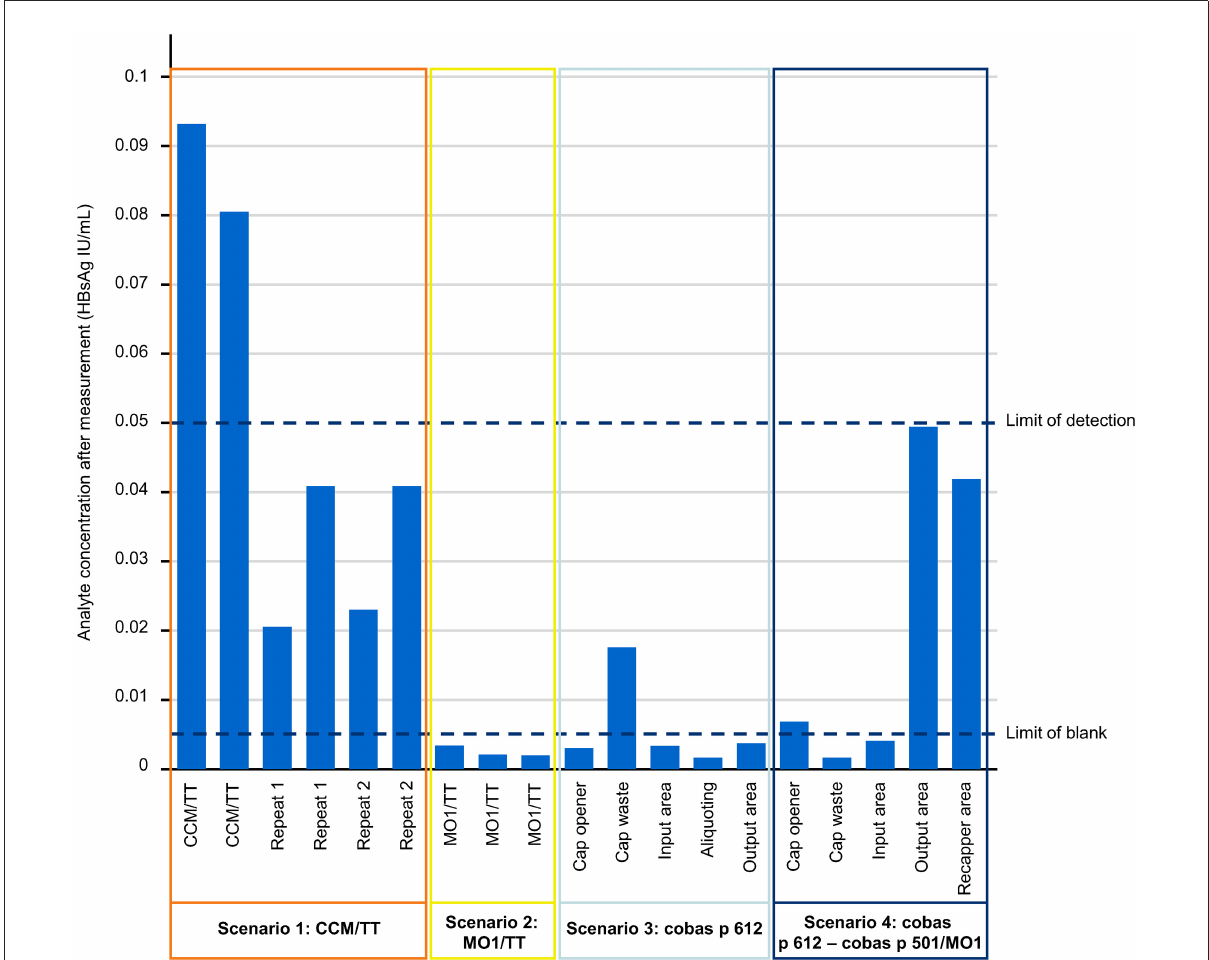
FIGURE4 The effective HBsAg analyte concentration from each of the testing scenarios investigated in the end-to-end laboratory workflow sub-study. Quantification of HBsAg was performed on the cobas e 801 analytical unit. CCM, cobas connection module; HBsAg, hepatitis B surface antigen; IU, international unit; MO1, manual output station 1; TT,